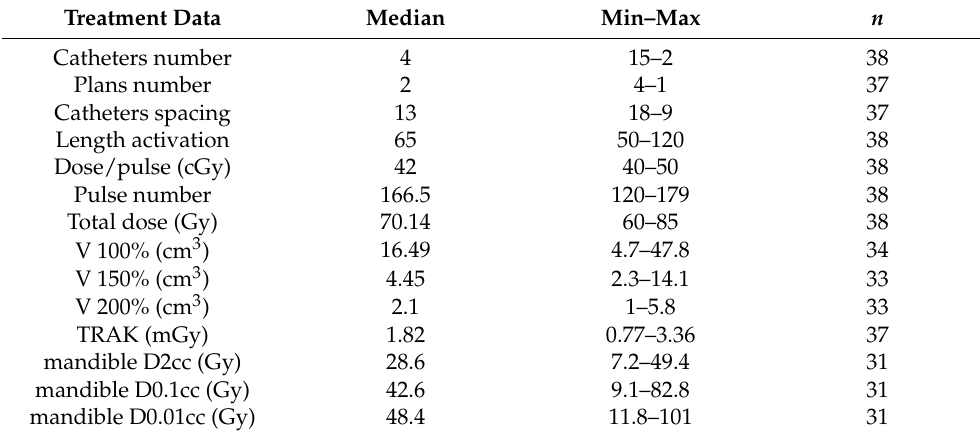
Table 2. Dosimetric